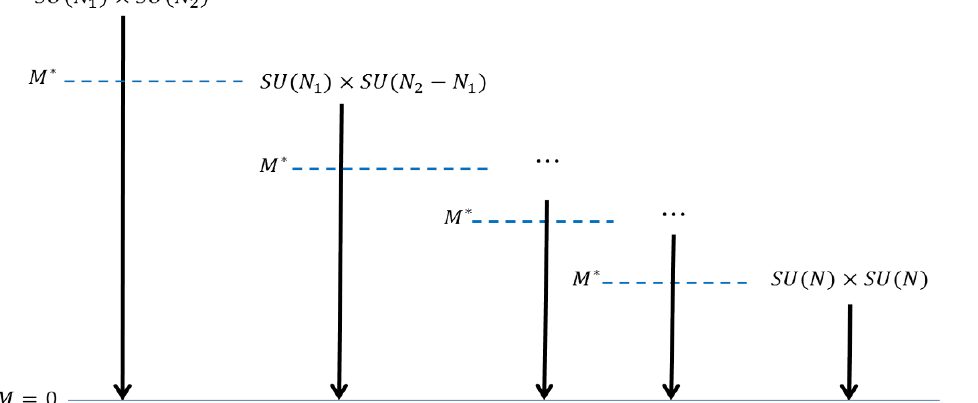
Figure 3 . Schematic illustration of the duality cascade. Starting from SU( N 1 ) (cid:2) SU( N 2 ) on the left, as we lower the mass of the fermion we uncover dual theories that describe the correct evolution of the phase diagram. The last step of the cascade is the SU( N ) (cid:2) SU( N ) theory where N = gcd ( N 1 ; N 2 ) (assuming here N (cid:29) 1). The massless point M = 0 is the same for all the